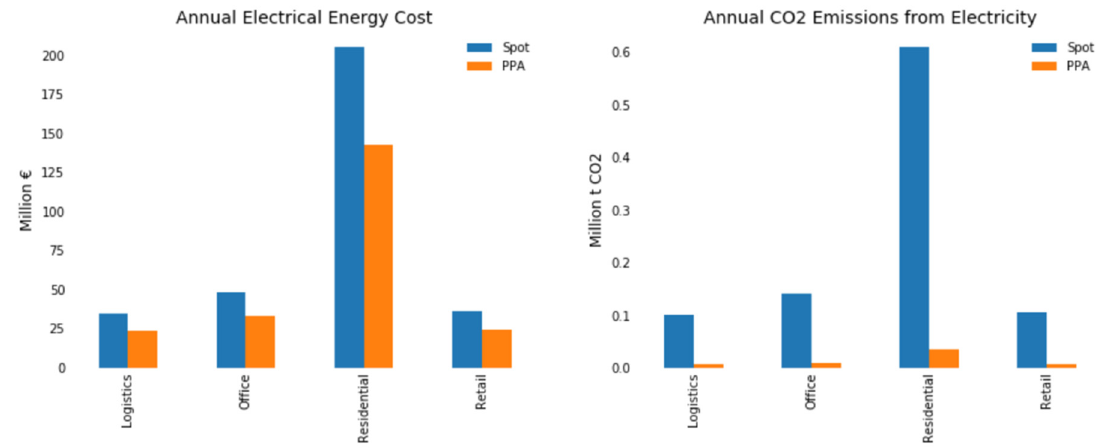
Figure 3. Annual electrical energy costs (not including tax and distribution) and emissions for the building stock of the Helsinki Metropolitan Area. Hourly spot data from Nordpool for the year of 2019 are used to calculate the costs, and for power purchase agreements (PPAs), a 33 €/MWh average is used.